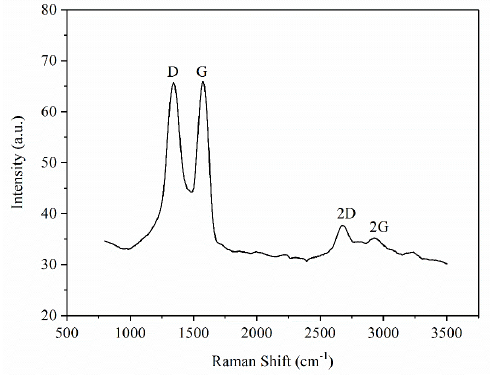
Figure 1. Raman spectrogram of NG.